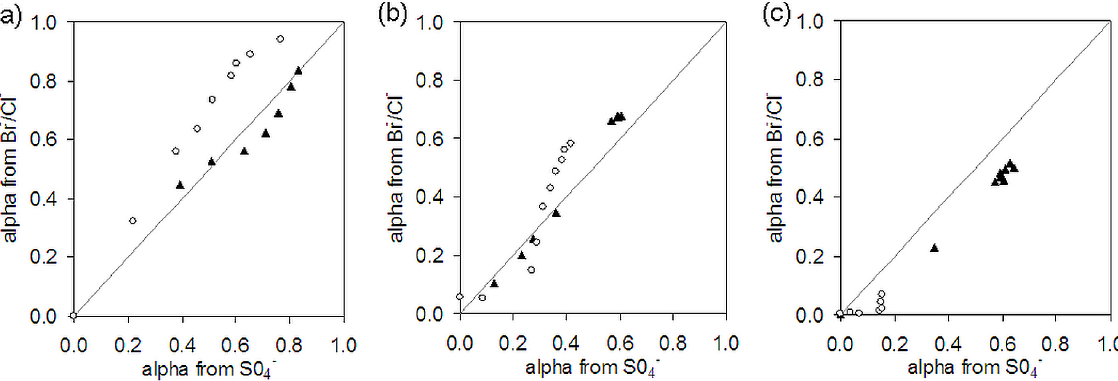
Figure 5. EMMA model results for the centrally located piezometers A1 (a) , B1 (b) and C1 (c) . The full triangles are estimates for the first day of the experiment and the open dots represents second day of the experiment. The grey line is the 1 : 1